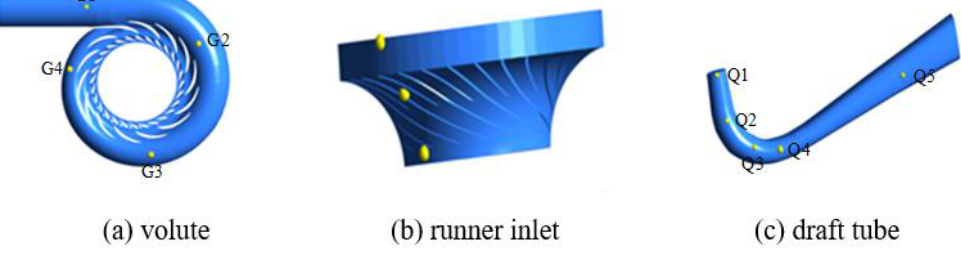
Figure 4. Location of monitoring points in the Francis